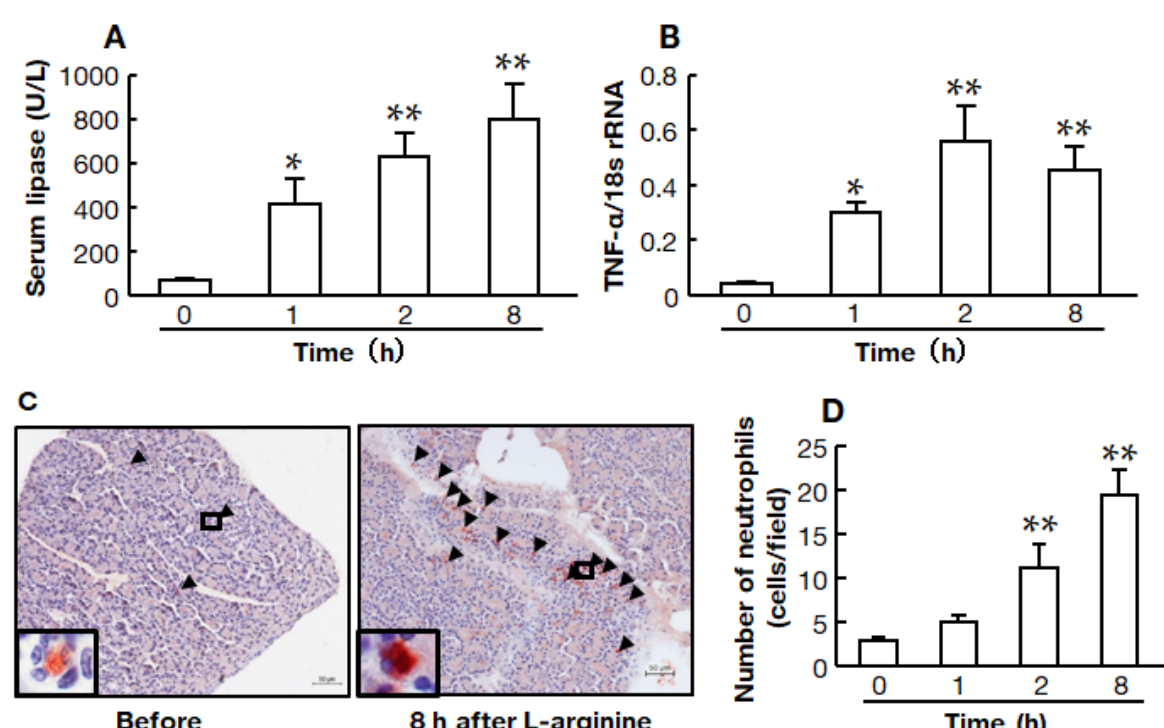
Figure 2. Time courses of serum lipase, pancreatic TNF- α mRNA levels, and neutrophil numbers after L-arginine injection. Serum lipase ( A ) and pancreatic TNF- α mRNA levels ( B ) in hamsters before and 1, 2, and 8 h after the injection of 3.0 mg/kg L-arginine (before: n = 6, 1 h: n = 6, 2 h: n = 6, 8 h n = 5). Representative images of a pancreas immunostained with anti-neutrophil elastase antibody from hamsters before (left image) and 8 h (right image) after the injection of L-arginine ( C ). Arrows indicate neutrophil elastase-positive cells. Original magnification 200 × (inset: 1000 × ) ( C ). Number of neutrophil elastase-positive cells (neutrophils) in the pancreas before and 1, 2, and 8 h after the injection of 3.0 mg/kg L-arginine (before: n = 6, 1 h: n = 6, 2 h: n = 6, 8 h: n = 5) ( D ). Values represent means ± SEM. * p < 0.05 and ** p < 0.01 vs. before.